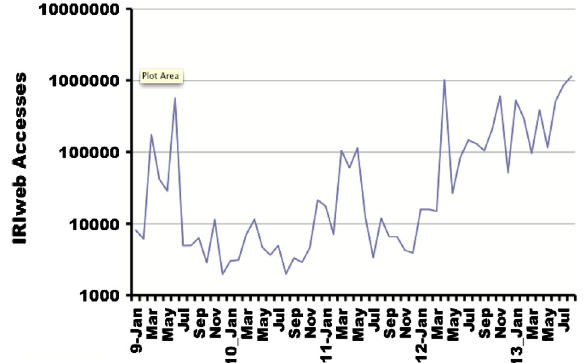
Fig. 8. Monthly accesses to the IRIweb online interface from January 2009 to